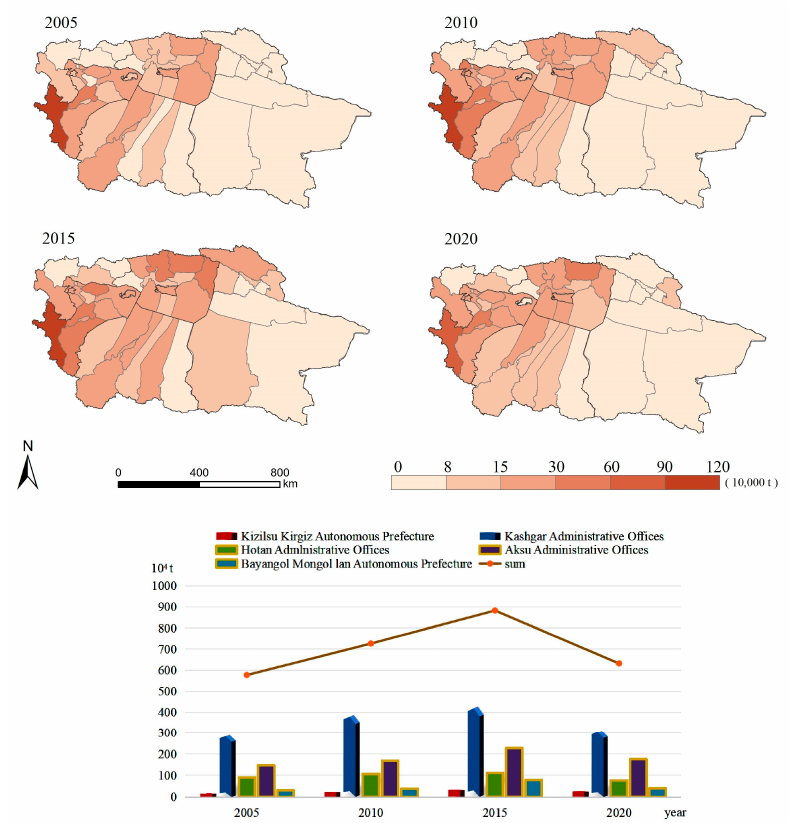
Figure 2. Spatial distribution of grain production in the Tarim River Basin.